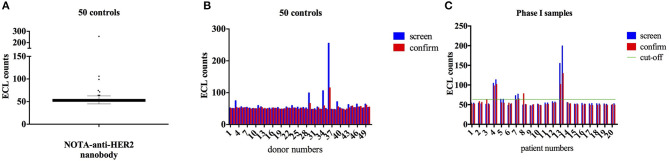
ECL measurement of ADA in samples from healthy volunteers and from patients. Anti-drug antibody (ADA) analysis by Electrochemiluminescence (ECL) for 50 serum samples of healthy donors for cut-off point determination (A,B) and for the 20 samples of patients enrolled in the phase I PET study, both prior to and 3 months after Nb-tracer injection (C). Four patients out of 20, showed a positive ECL result (i.e., a signal above the screening cut-off, indicated by a green horizontal line) of which according to the confirmation assay, one patient (#13) possesses ADA in the serum both prior to and 3 months after Nb-injection.